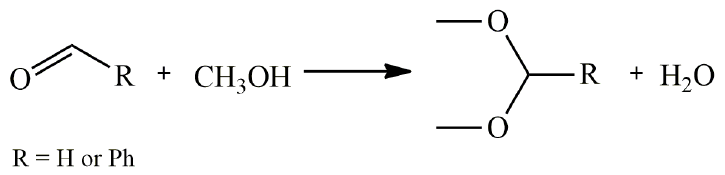
Figure 1. Acetalization of aldehydes with methanol.